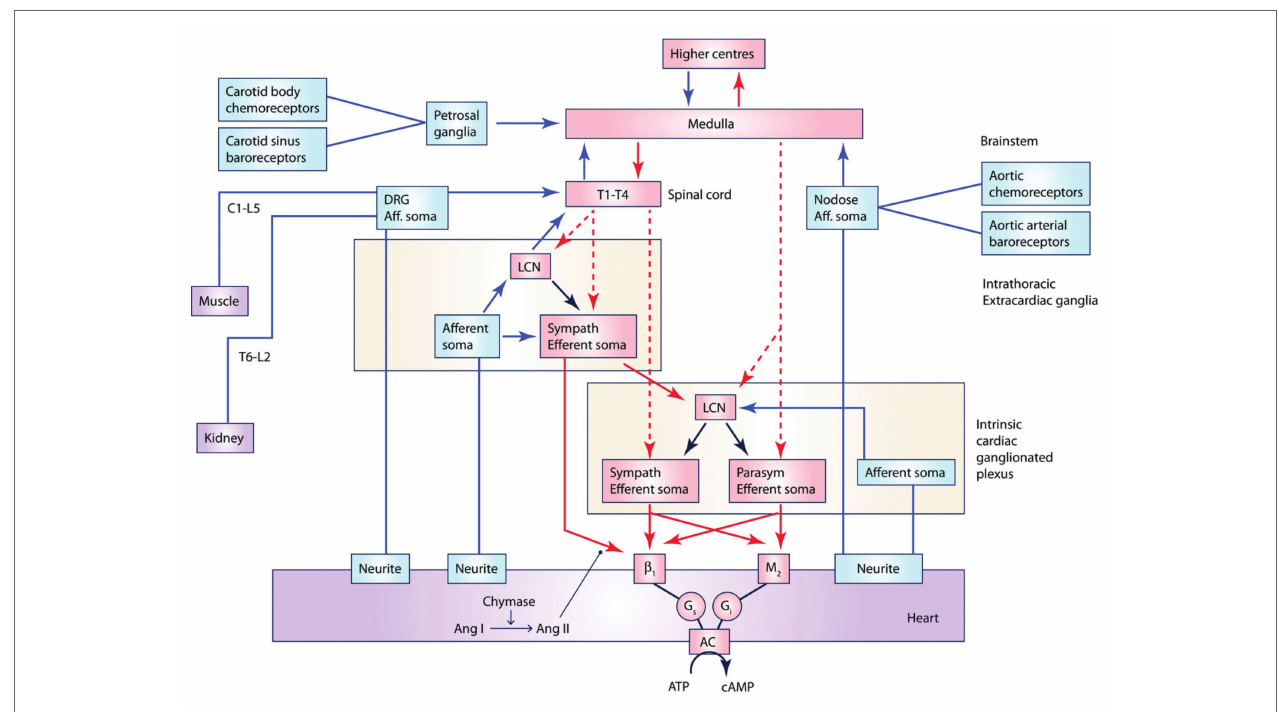
FIGURE 2 | Interactions between central nervous system, peripheral ganglia, and the ICNS. Multiple interdependent feedback loops regulate regional cardiac mechanical and electrical function. At the level of the heart, sensory (blue) neurons provide input directly and indirectly through the ICNS, peripheral ganglia, and spinal cord, which are capable of engaging cardiocentric reflexes. Converging inputs result in activation of adrenergic or muscarinic receptors as well as receptors for peptide co-transmitters such as neuropeptide Y (not displayed). Preganglionic sympathetic and parasympathetic efferent fibers project (red, dashed) to the ICNS, including to LCNs, and postganglionic sympathetic fibers (red, solid) also directly to the myocardium. The ICNS acts as the final common pathway for cardiac control, though interactions occur at all levels. Input from chemoreceptors, baroreceptors, as well as neurohormonal factors such as angiotensin II and circulating epinephrine (not displayed), also modulate cardiac function. Ang I, angiotensin I. Ang II, angiotensin II. LCN, local circuit neuron. Adapted from Ardell et al. (2016) with